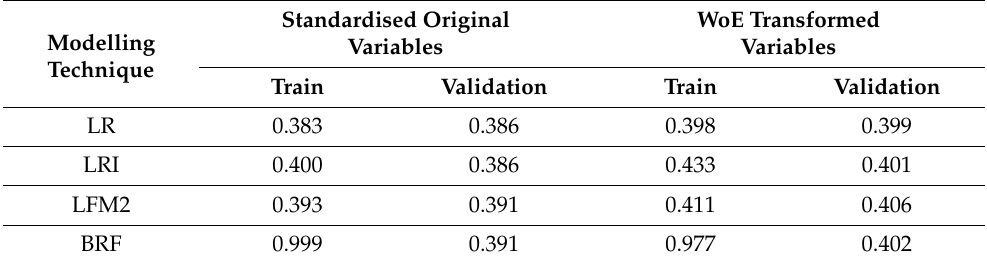
Table 17. F1 scores obtained by the models for the credit scoring data